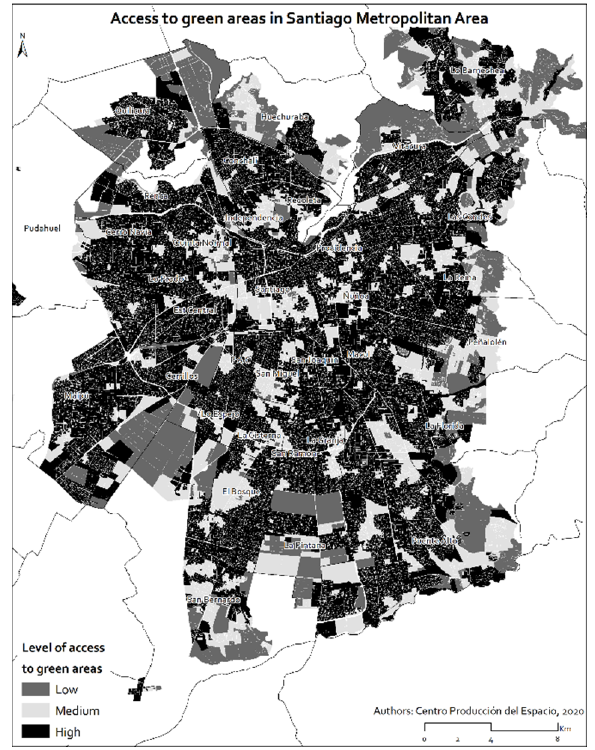
Figure 6. Access to Green Areas in the Santiago Metropolitan Area. Source: authors.